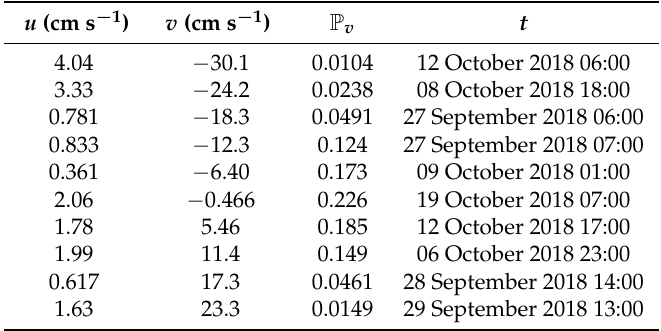
Table A1. Point values of representative velocities from the Cherry Point data ( u and v ), the joint probability of those velocities occurring ( P v ) and the selected time step ( t